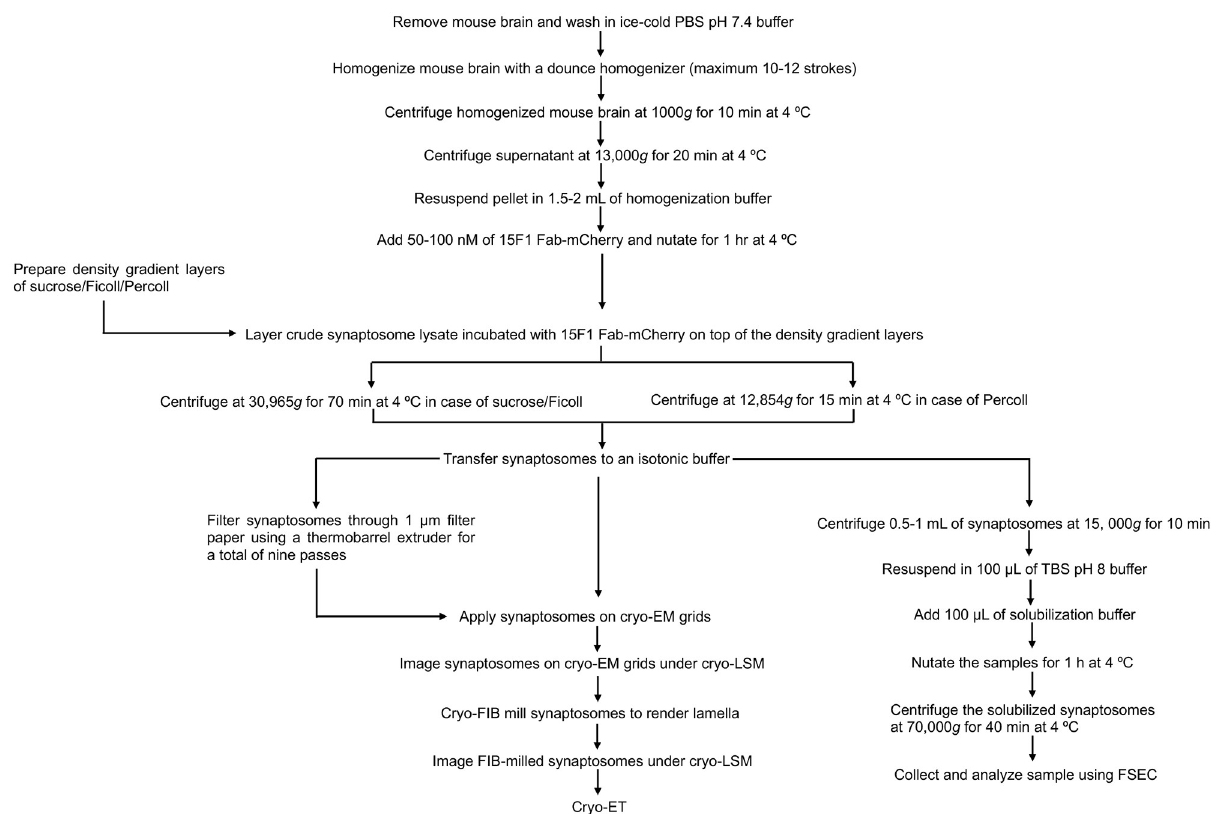
Fig 1. Workflow for the preparation of cryo-FIB milled glutamatergic synaptosomes for cryo-ET studies.